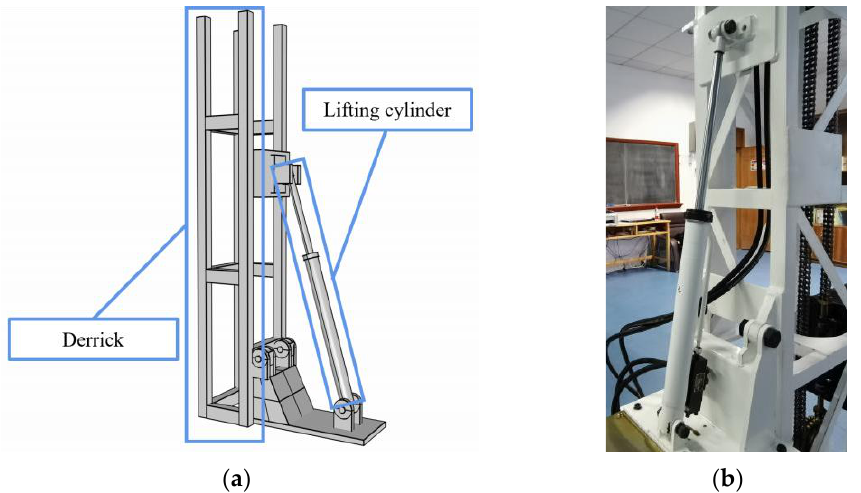
Figure 5. Model and physical drawing of the lifting cylinder. ( a ) Model drawing; ( b ) Physical drawing.